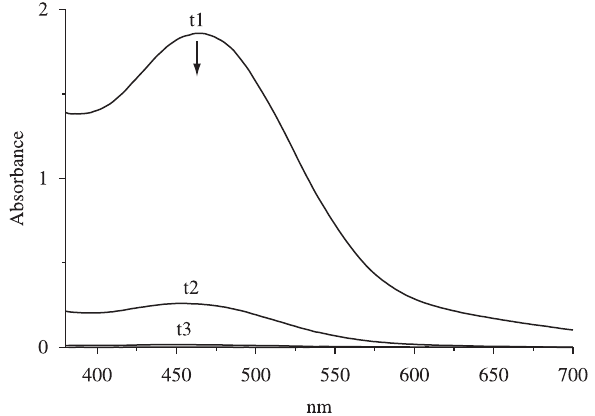
Figure 1. Reaction of NTCDA with Al and OH – = 300 mg, in 20 mL H